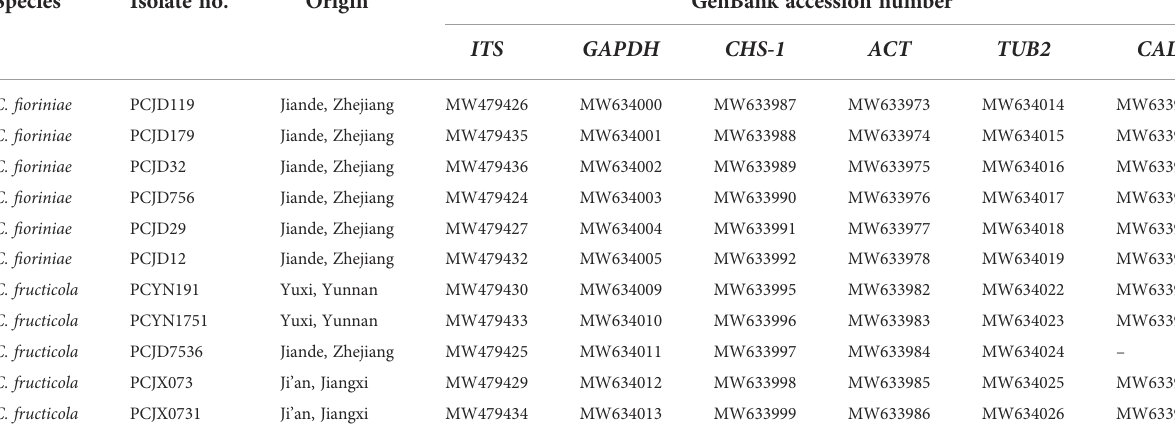
TABLE 4 List of 11 representative isolates of two Colletotrichum spp. collected from pecan in China. Species Isolate